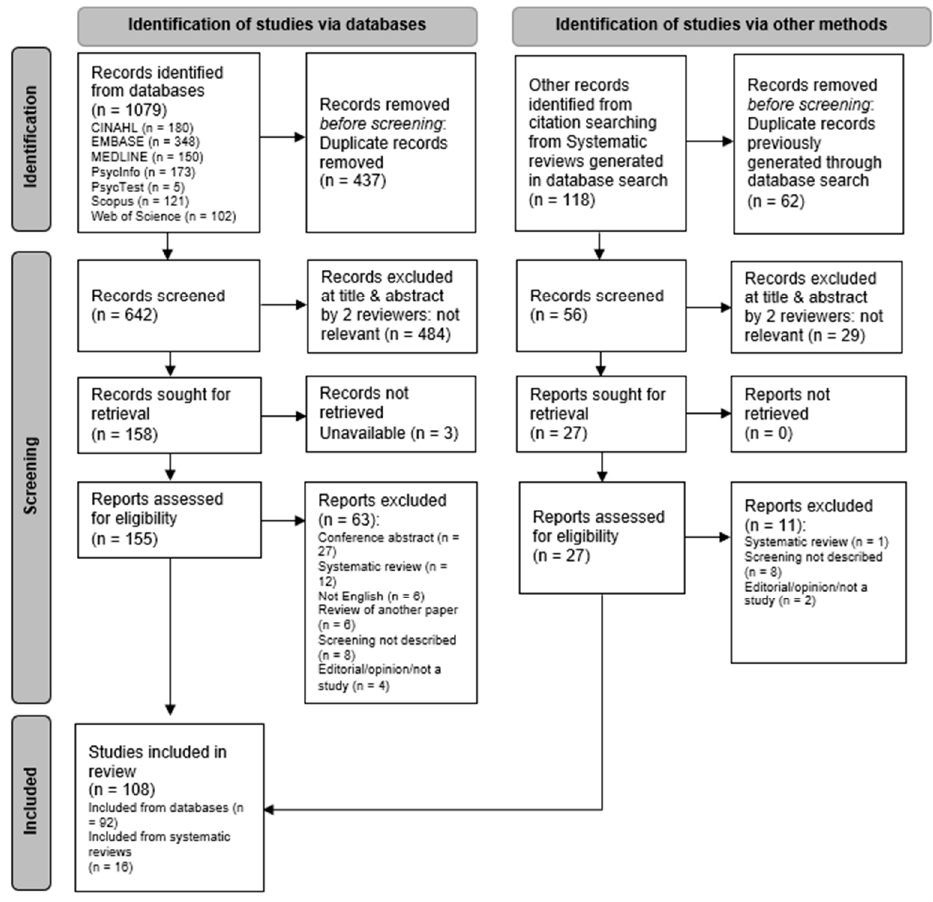
Figure 1. PRISMA flow diagram [63].